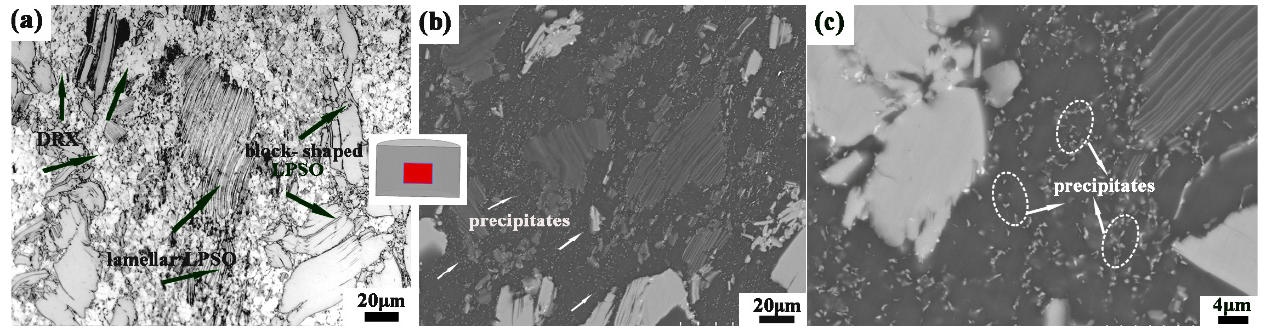
Figure 2. OM and SEM-BSE images of the initial billet: ( a ) OM map; ( b , c ) SEM-BSE maps. EBSD analysis paralleled to the loading direction of the initial billet is presented in Figure 3. The change of grain orientation can be observed by the change of color in Figure 3a. Thus, it can be noticed that small orientation differences were inside grains were very fine, and the average grain size was 3.02 µ m as shown in Figure 3b. In